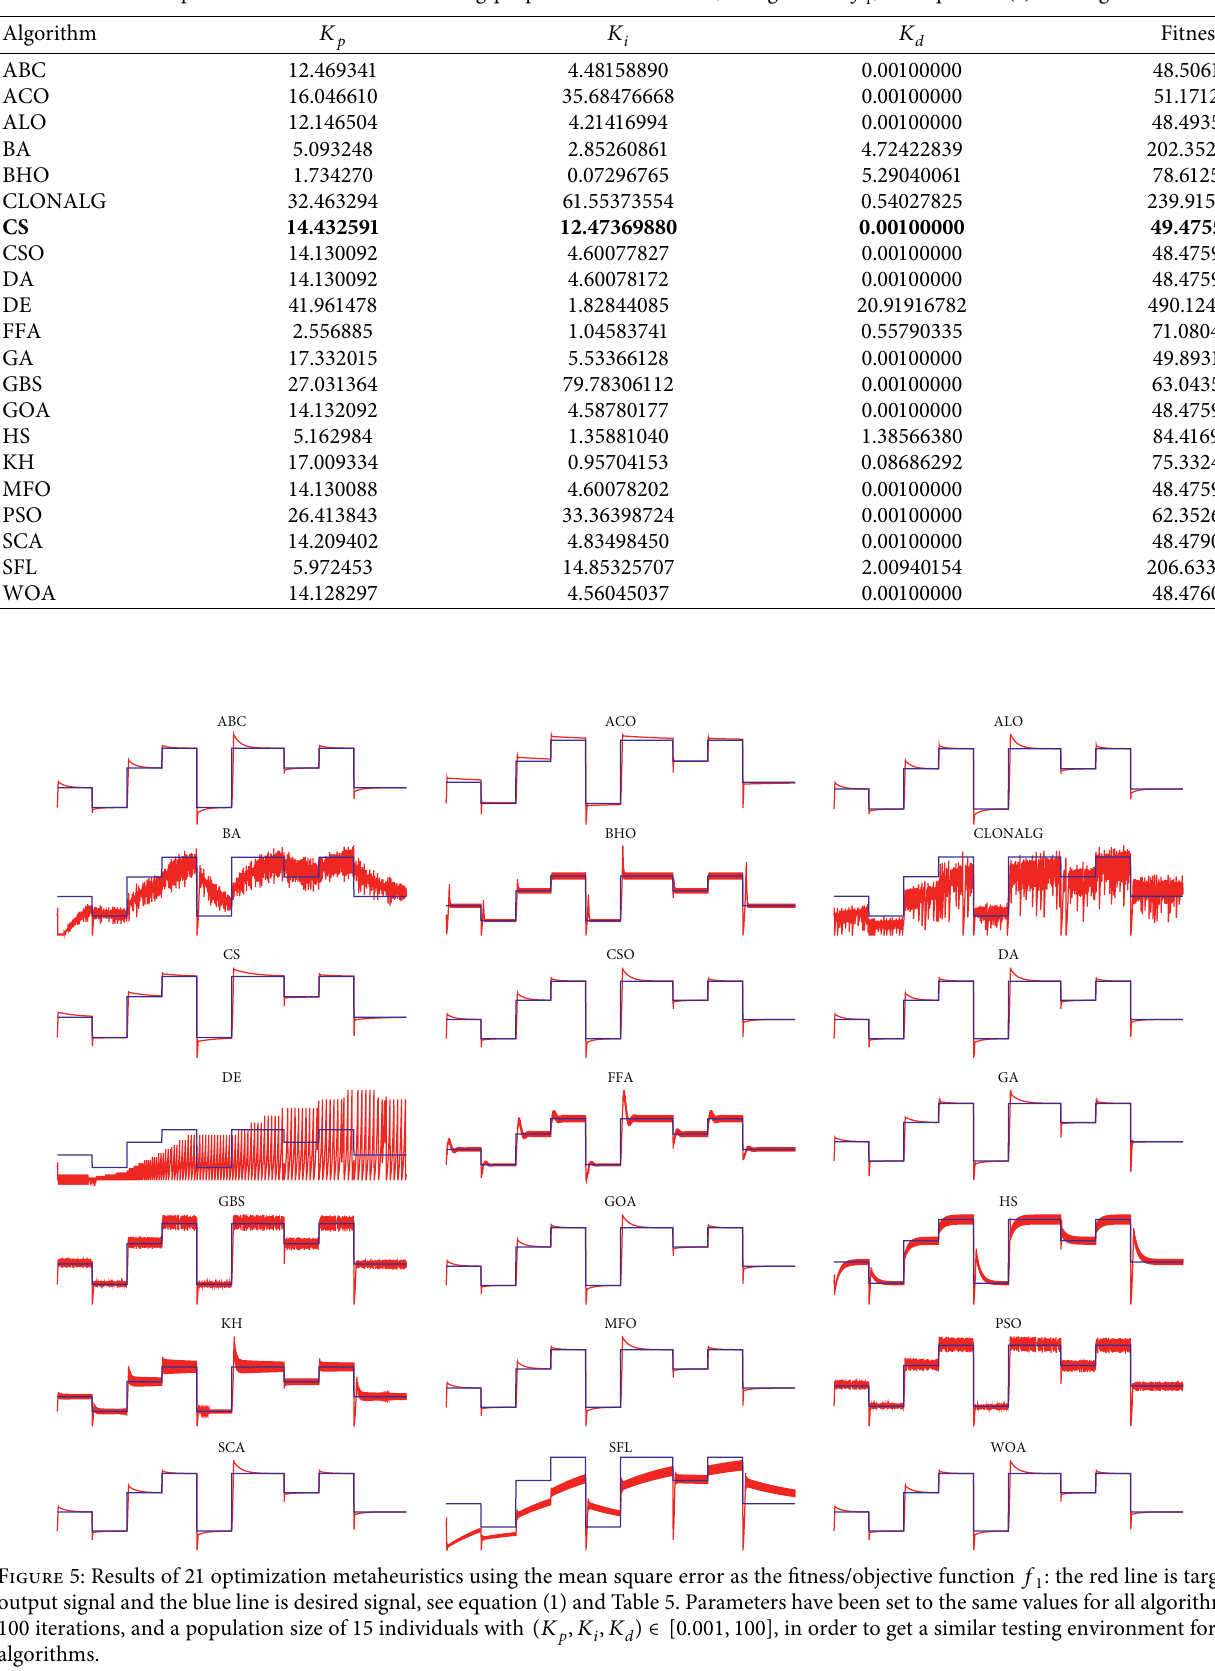
Table 5: Optimization solution values using proposed metaheuristics, using fitness f